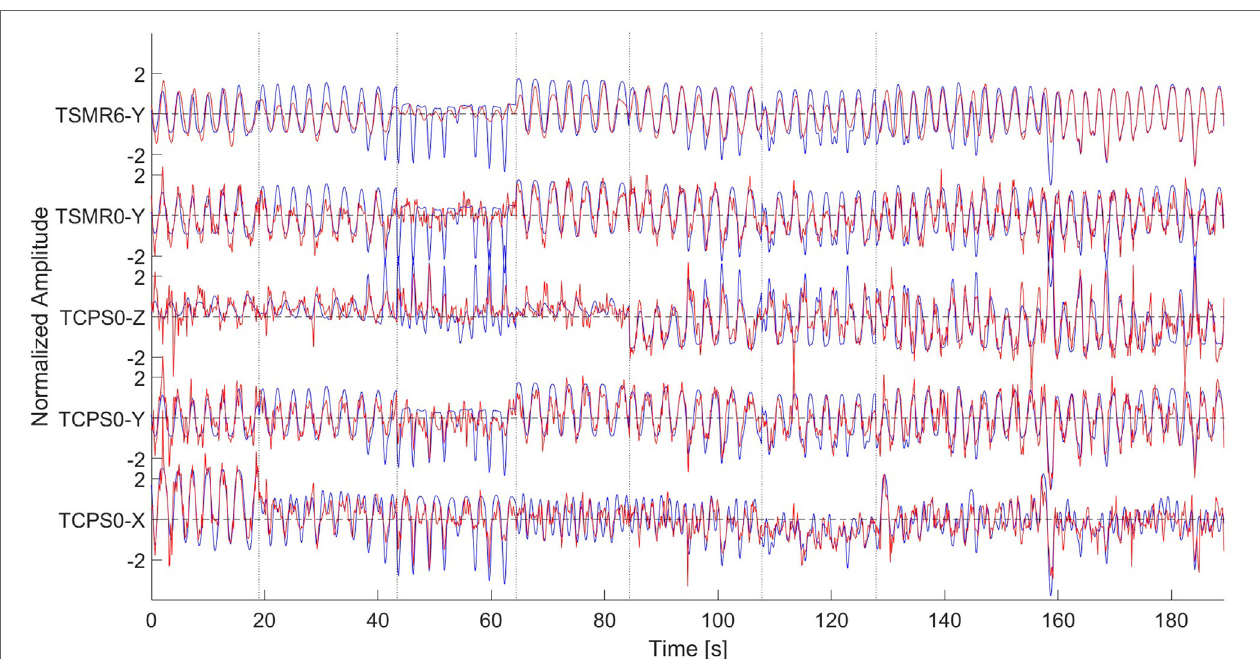
FigUre 9 | reconstruction of the signal using different methods . From bottom to top, TCPS 0 for the x dimension, TCPS 0 for the y dimension, TCPS 0 for the z dimension, TSMR 0 for the y dimension, and TSMR 6 for the y dimension. In all the cases, blue lines indicate the original movement and red lines the reconstructed. Dotted vertical lines indicate different phases (described in Figure 1 ). The amplitude is normalized so it has a mean of zero and SD of 1. The data are from subject